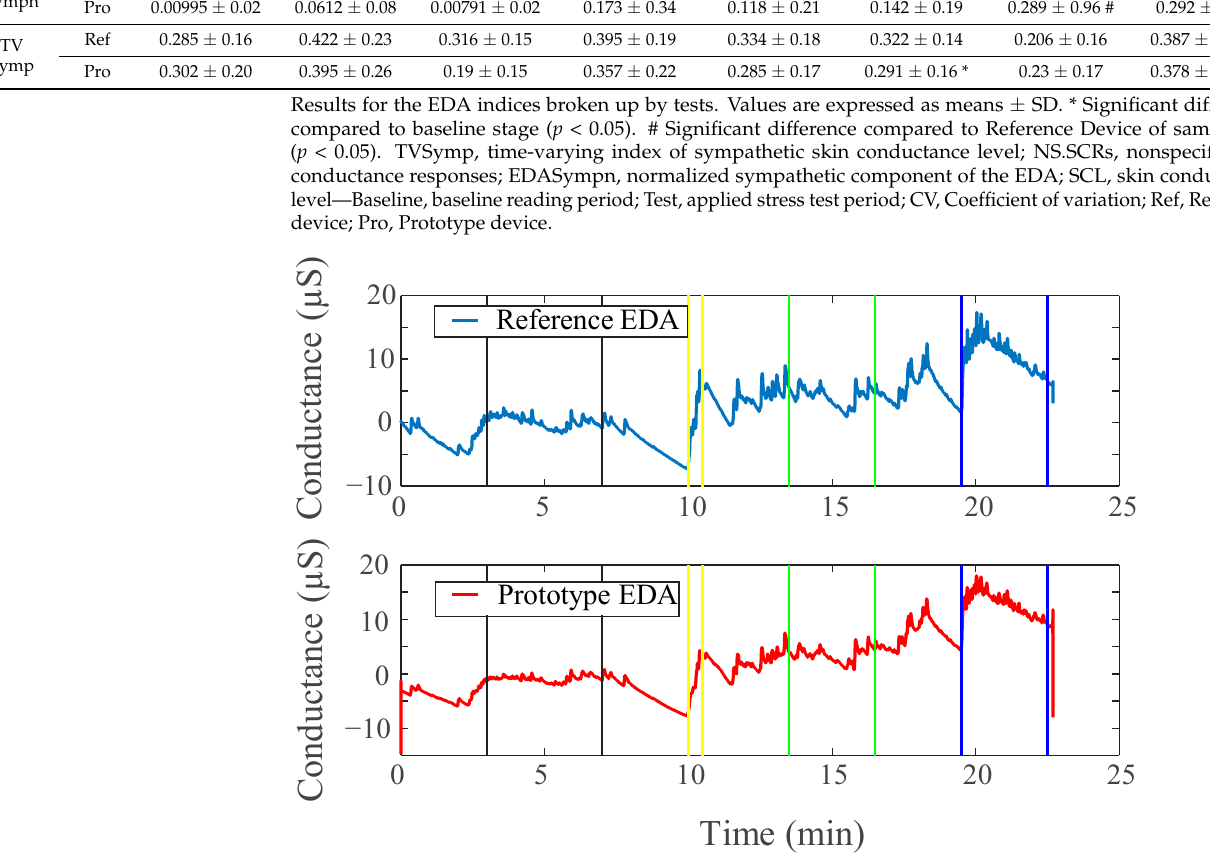
Figure 6. Raw EDA data from both devices, lines indicate the four different tests: black (stroop), yellow (tilt period), green (bicep), blue (combination, both stroop and bicep tests simultaneously). EDASympn and TVSymp also demonstrate a similar pattern when comparing the output of the reference and our device. The shared trend of TVSymp between the Table 2. Results for EDA Indicies.